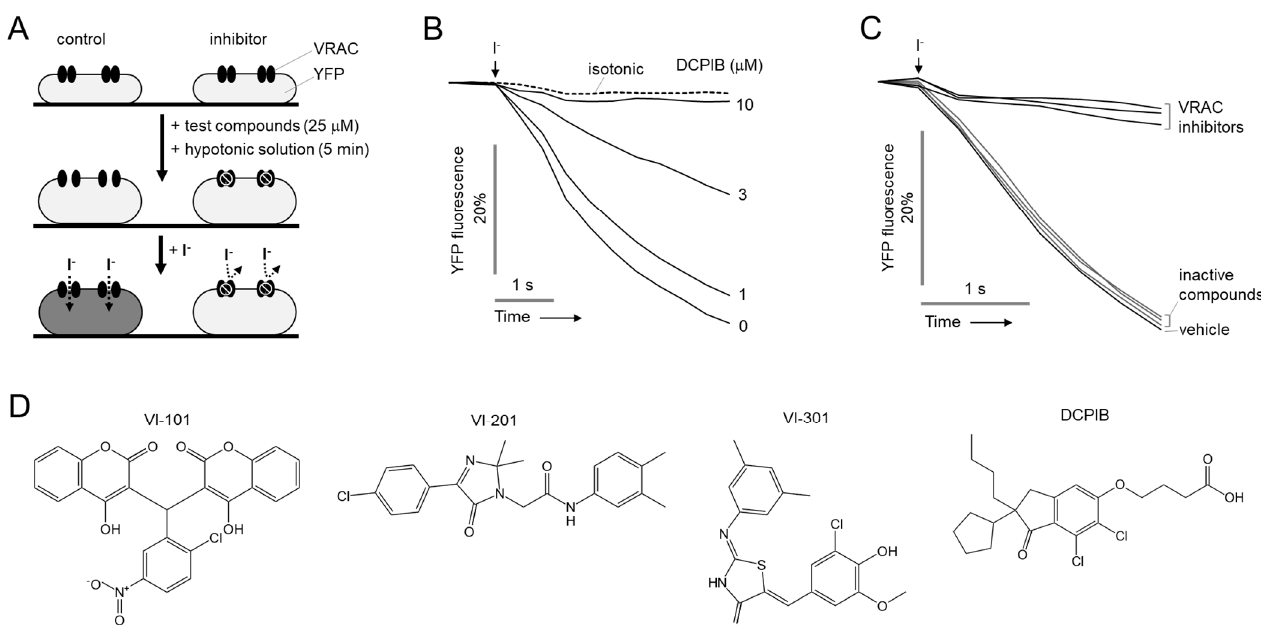
Figure 1. Identification of novel VRAC inhibitors. ( A ) Principle of high − throughput screening assay. ( B ) Representative YFP fluorescence traces for VRAC activity. LN215 cells were treated with indicated concentrations of DCPIB for 5 min. VRAC was activated by application of hypertonic solution for 5 min. ( C ) Representative YFP fluorescence traces for VRAC inhibitors and inactive compounds. ( D ) Chemical structures of novel VRAC inhibitors (VI-101, VI-201, and VI-301) and DCPIB.